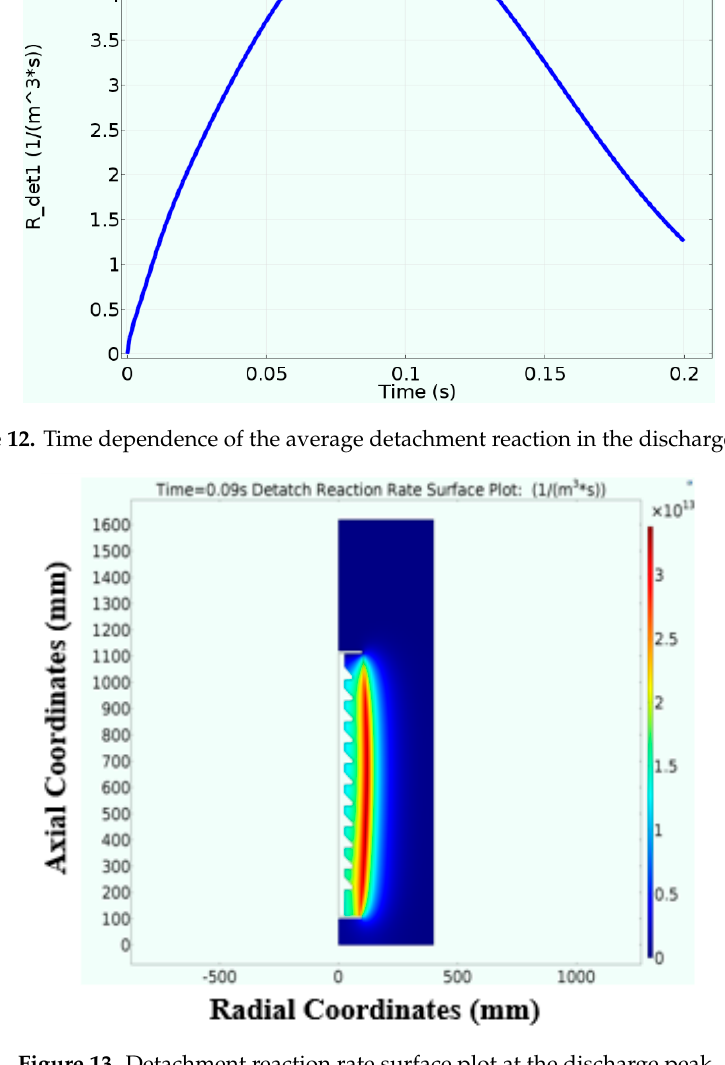
Figure 13. Detachment reaction rate surface plot at the discharge peak.